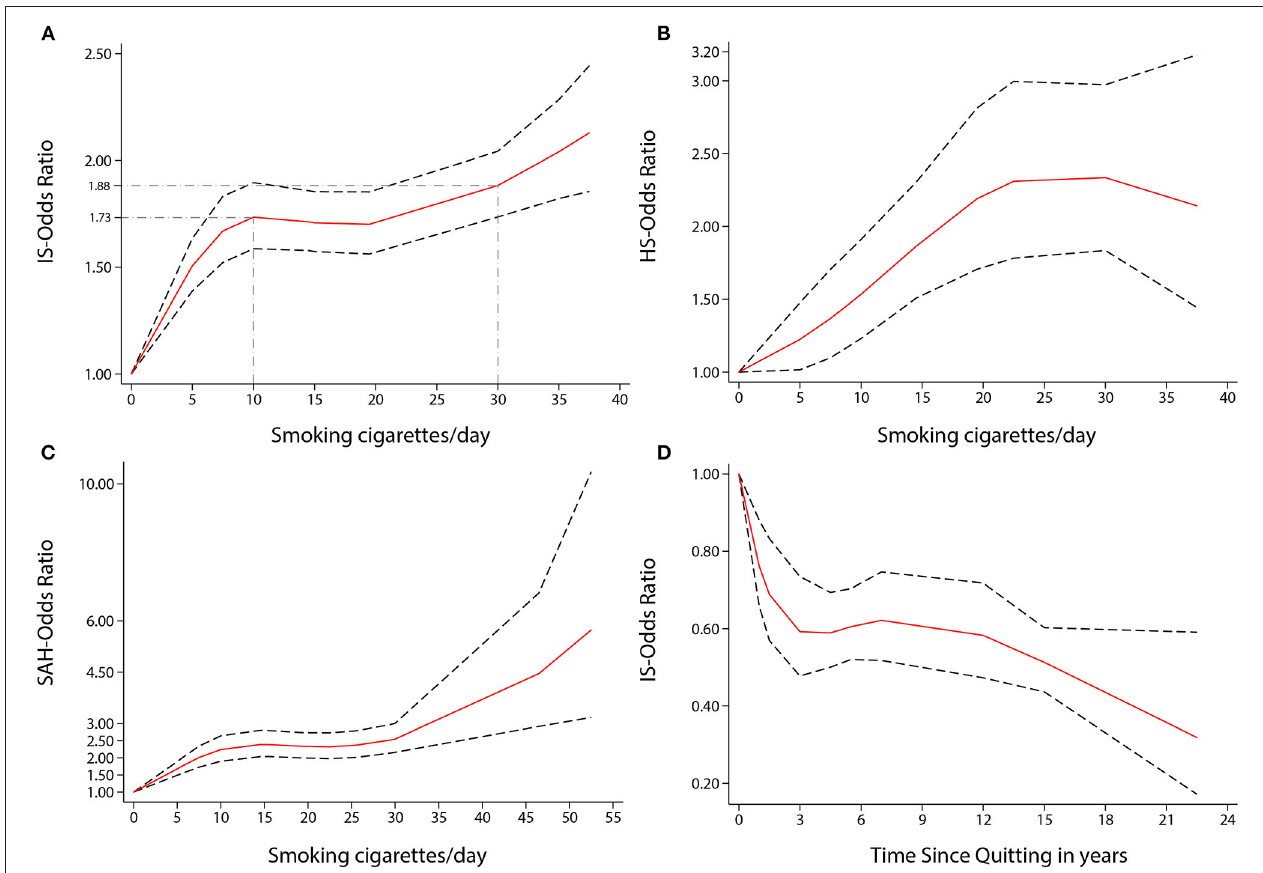
FIGURE 4 | Non-linear dose-response analyses of smoking/quitting and risk of IS/HS/SAH in meta-analysis. (A) Association between dose of cigarette consumption and risk of Ischemic stroke incidence restricted cubic splines with 4 knots (0, 5, 15, 37.5 CPD) and 0 CPD as reference. P non-linearity = 0.0000. Solid line represents the estimated OR and the dashed lines represent the 95% CI. OR = 1.73, 95% CI 1.59–1.90, for 10 CPD; OR = 1.88, 95% CI 1.74–2.04, for 30 CPD. (B) Association between dose of cigarette consumption and risk of Hemorrhagic stroke incidence restricted cubic splines with 4 knots (0, 5, 19.5, 37.5 CPD) and 0 CPD as reference. P non-linearity = 0.0447. Solid line represents the estimated OR and the dashed lines represent the 95% CI. OR = 1.53, 95% CI 1.23–1.91, for 10 CPD; OR = 2.34, 95% CI 1.83–2.97, for 30 CPD. (C) Association between dose of cigarette consumption and risk of Subarachnoid Hemorrhage incidence restricted cubic splines with 4 knots (0, 6.5, 21, 49.5 CPD) and 0 CPD as reference. P non-linearity = 0.0002. Solid line represents the estimated OR and the dashed lines represent the 95% CI. OR = 2.24, 95% CI 1.90–2.64, for 10 CPD; OR = 2.55, 95% CI 2.16–3.01, for 30 CPD. (D) Association between the length of time since quitting and risk of Ischemic stroke incidence restricted cubic splines with 4 knots (0, 1, 5.5, 22.5 year) and quitting 0 year as reference. P non-linearity = 0.0022. Solid line represents the estimated OR and the dashed lines represent the 95% CI. OR = 0.59, 95% CI 0.48–0.73, for 3 year; OR = 0.51, 95% CI 0.44–0.60, for 15 year; OR = 0.32, 95%